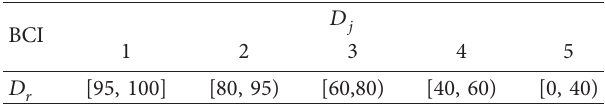
Table 1: The boundary of the grade assessment of bridge technical